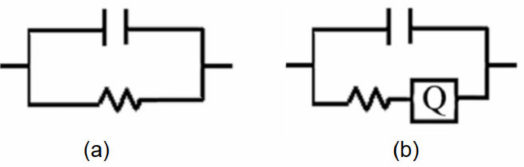
Figure 16. Equivalent circuits of sensor under different humidity levels; ( a ) very low RH (16% RH); ( b ) high RH (>30%